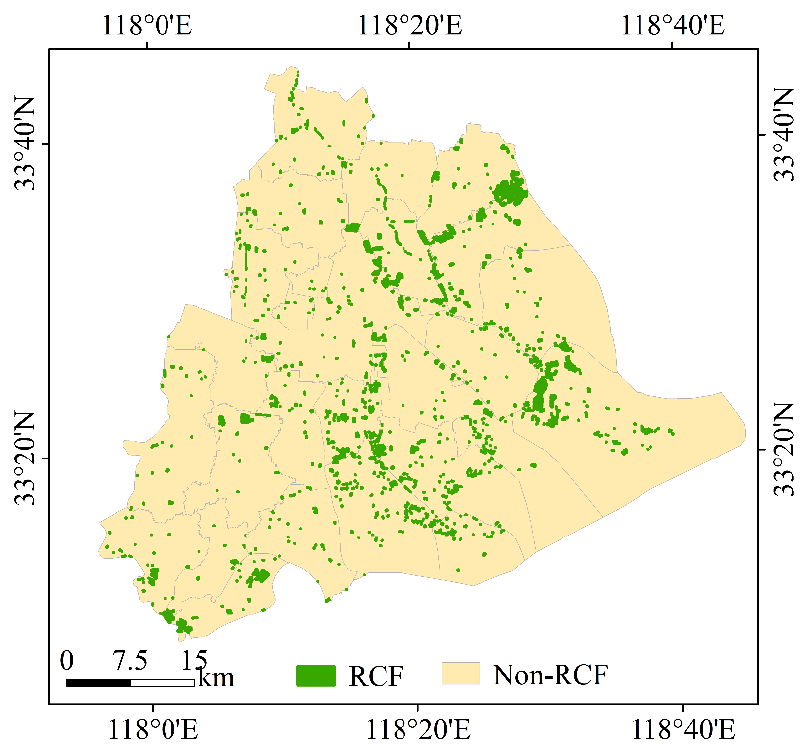
Figure 8. Spatial distribution of the RCFs of Sihong County in 2021, extracted by the BTFDOB method. Table 3. Accuracy evaluation of the classification results of 2021 based on the BTFDOB method.